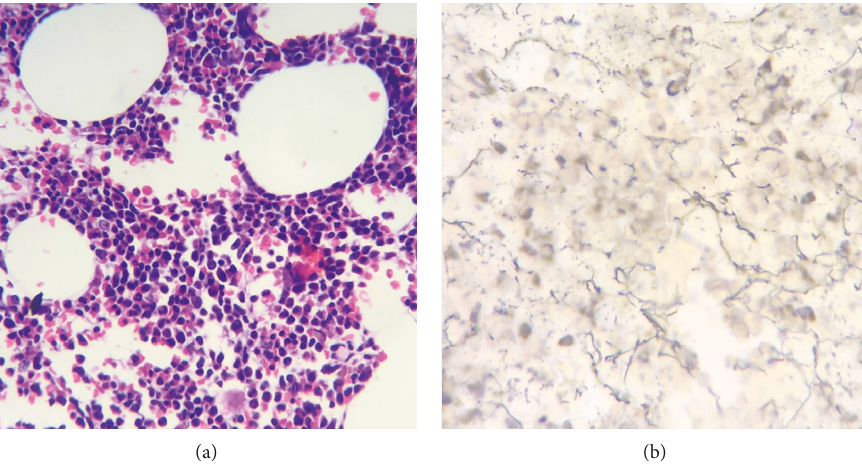
Figure 3: BM trephine biopsy. Normocellular marrow with trilineage hematopoiesis (a). Reticulin staining showing no significant fibrosis